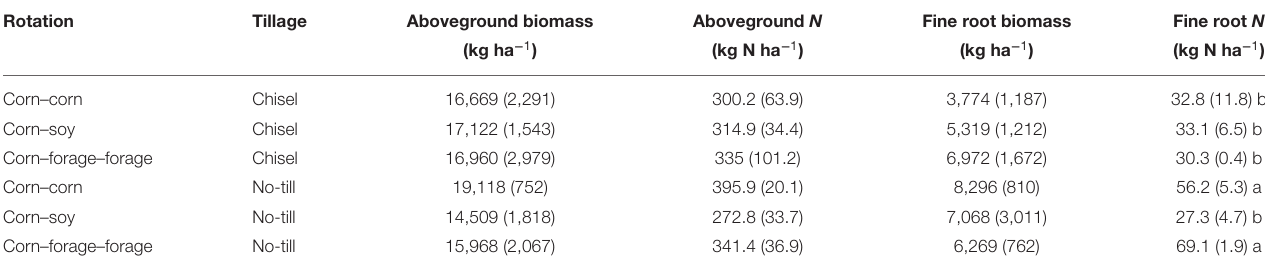
TABLE 2 | Mean and (SE) ( n = 3) of biomass and nitrogen content for total aboveground production and fine root production sampled at harvest (October 2020) from a long-term trial comparing tillage and crop rotational diversity in Northwest Ohio.